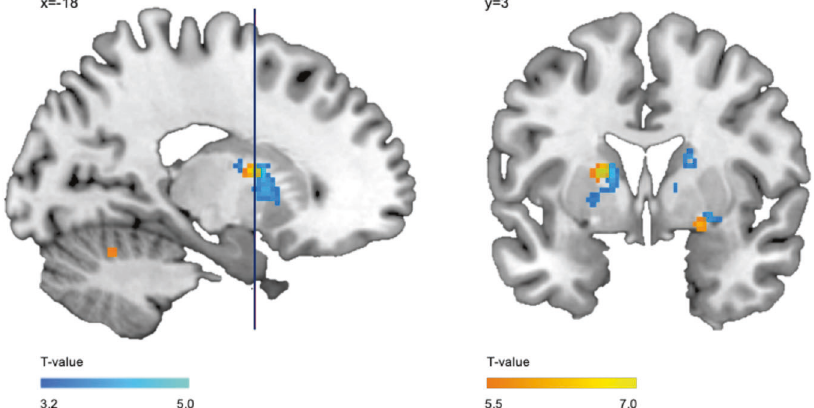
Fig. 5 fMRI results: activation pattern during neutral face processing. Blue: decreased activation after the 4-week intervention in the probiotics group during neutral face processing. Red: increased activation in depressive patients (i.e. probiotics and placebo groups combined at baseline) compared to healthy controls during neutral face